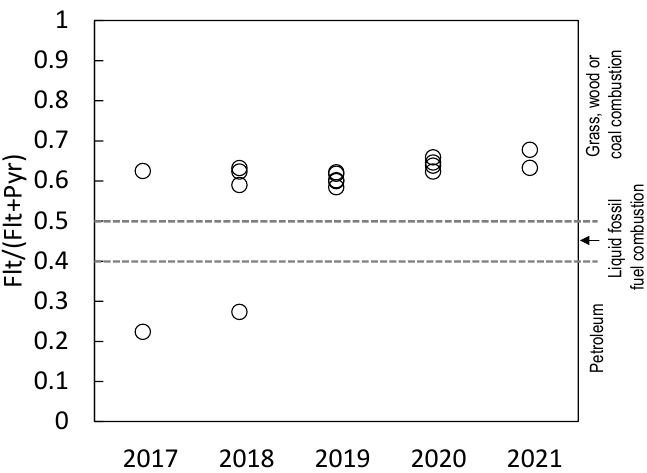
Figure 11. Behaviors in the diagnostic ratio of the forest site using winter data of each year.